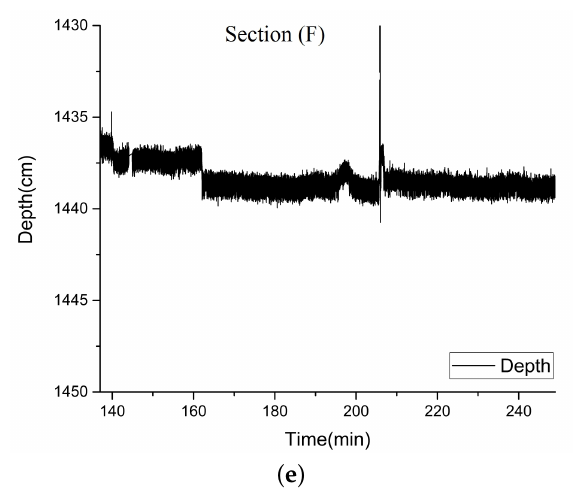
Figure 8. ( a ) Depth response of the sensor during the measurement over 4 h, ( b ) Depth response of the sensor in the sections (A) and (C) from ( a ), ( c ) Depth response of the sensor in the section (E) from ( a ), ( d ) Depth response of the sensor in the section (G) from ( a ), ( e ) Depth response of the sensor on the floor in the section (F) from ( a ).